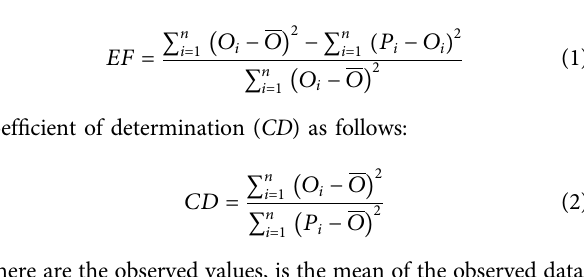
Frontiers in Earth Science |